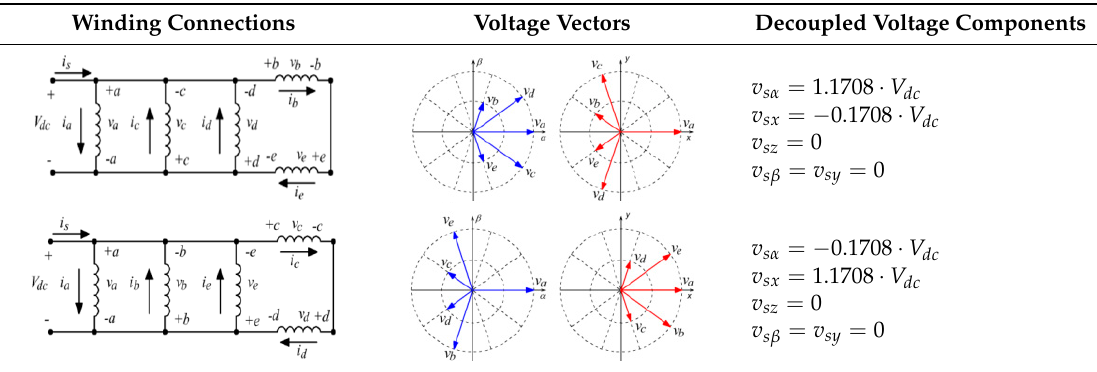
Table 1. Two available windings’ arrangements in a five-phase induction machine for the single-phase standstill estimation procedure.